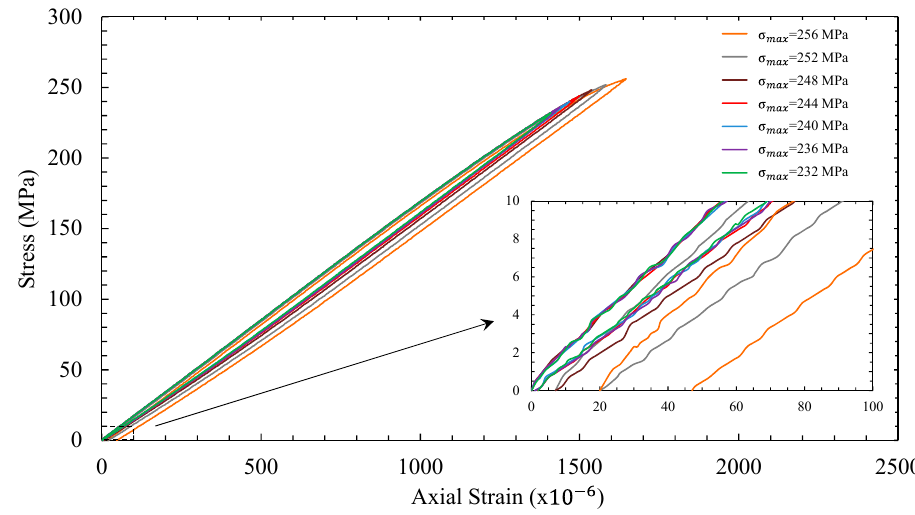
Figure 9. Incremental cyclic uniaxial test to distinguish the elastic limit of 316L stainless steel.